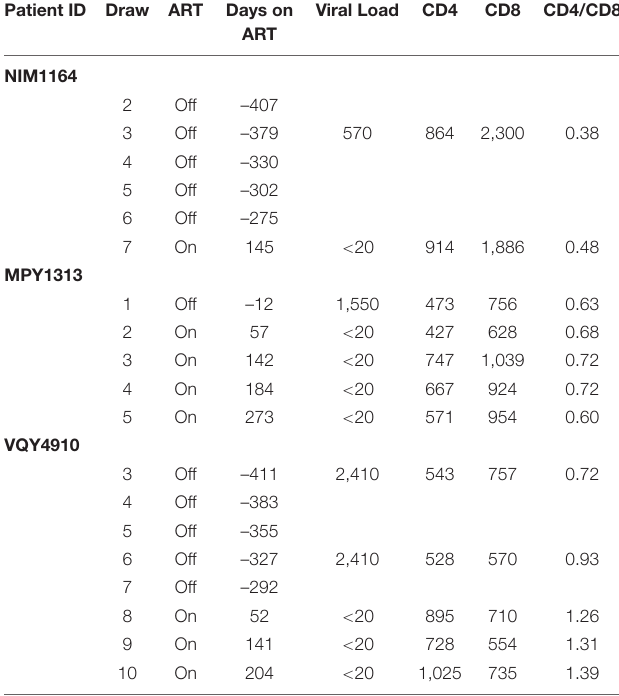
TABLE 3 | LVL subjects placed on ART. Patient ID Draw ART Days on